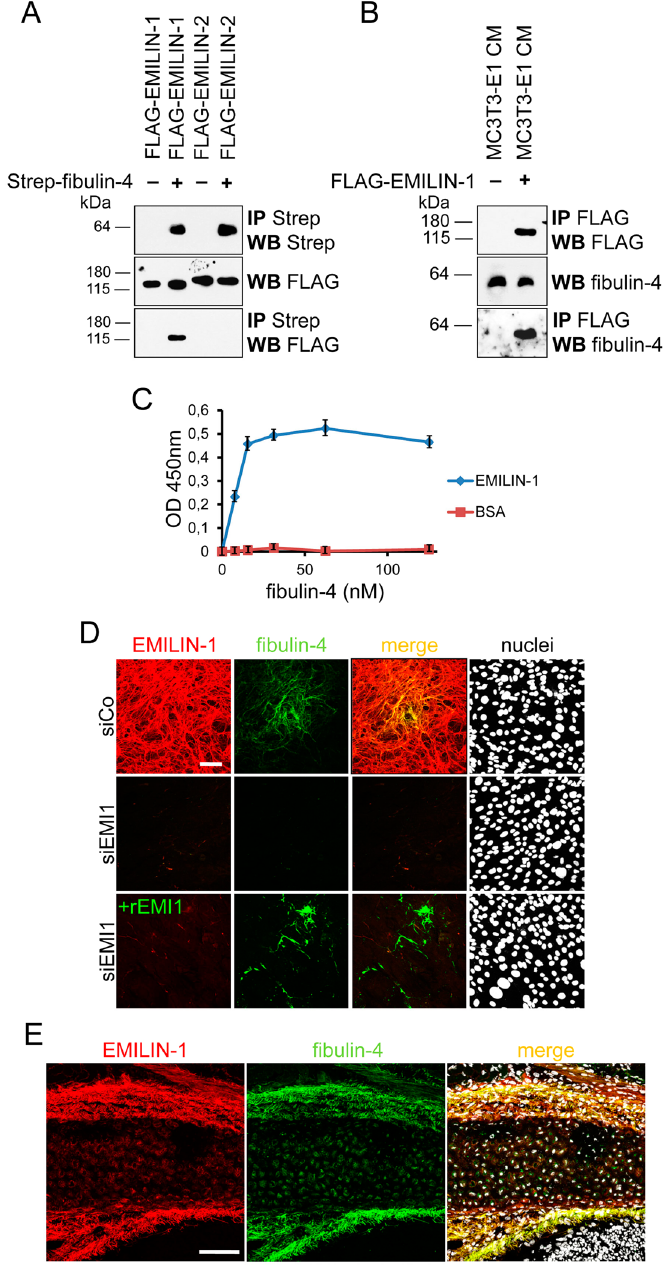
Figure 5. EMILIN-1 binds to fibulin-4, promotes fibulin-4 fiber formation in the ECM of MC3T3-E1 cells, and co-localizes with fibulin-4 in calvarial bone. ( A ) HEK293 EBNA cells were transfected with plasmids coding for murine EMILIN-1 and EMILIN-2 with a FLAG tag placed at their N-terminus. The obtained conditioned media were subjected to co-precipitation by incubation with recombinant 2 × strep-tagged murine fibulin-4. After washings, the elution fraction was analyzed by western blot with the indicated antibodies. ( B ) Conditioned media from control and FLAG-EMILIN-1 overexpressing EBNA cells were mixed with MC3T3-E1 conditioned medium. The mixed media were then subjected to immunoprecipitation with an anti-FLAG antibody and the resulting material probed by WB with a fibulin-4 specific antibody. ( C ) ELISA assay showing direct binding between coated recombinant human EMILIN-1 and soluble fibulin-4. ( D ) MC3T3-E1 osteoblasts were reverse transfected with a siRNA against EMILIN-1 (siEMI1) or with a control siRNA (siCo). Cells were grown on glass coverslip untreated or supplemented with 10 nM recombinant soluble EMILIN-1. After four days of culture cells were harvested, stained with indicated antibodies, and analyzed by confocal microscopy. Nuclei were stained with Hoechst. ( E ) Confocal immunofluorescence microscopy of EMILIN-1 and fibulin-4 on sagittal sections of newborn mouse skull shows co-localization of both proteins in calvarial bone. Scale bars, 75 μ